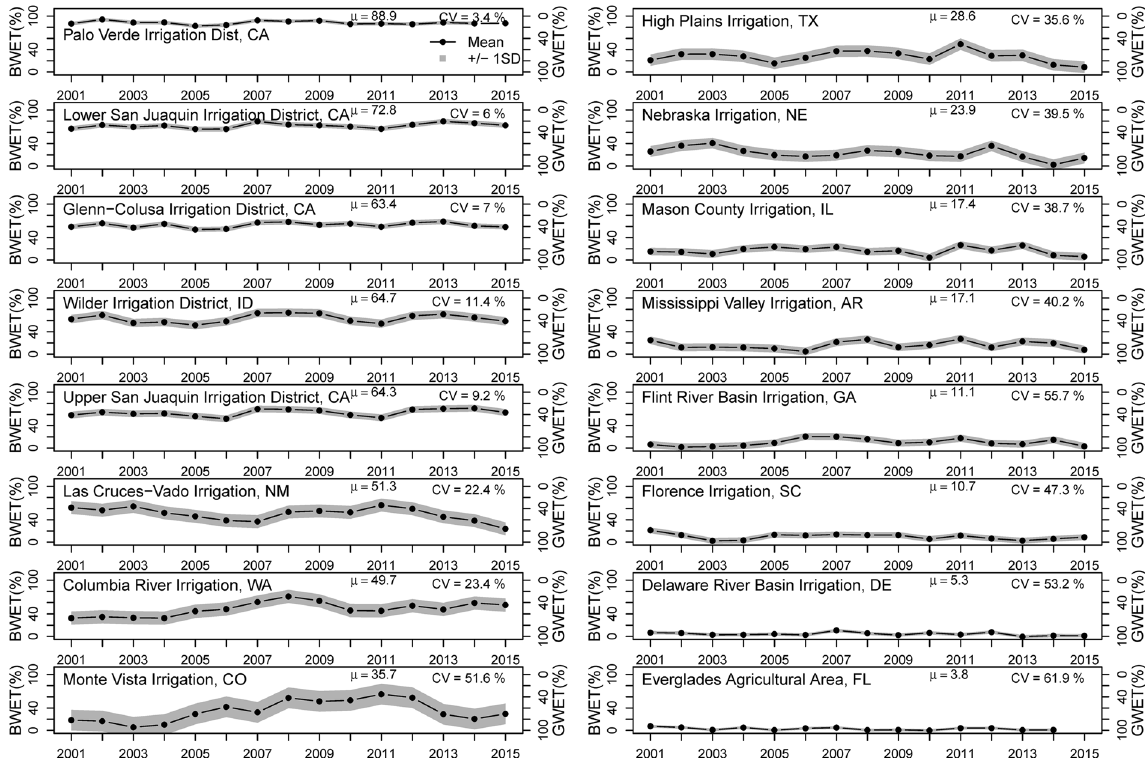
Figure 4. Time series plots (2001–2015) of average annual blue and green water ET (BWET and GWET) summarized for 16 irrigated areas in CONUS. The gray area denotes ± 1 standard deviation. μ and CV indicates the mean and coefficient of variation for BWET. The figure was generated using R 3.3.0 software https://www.r-